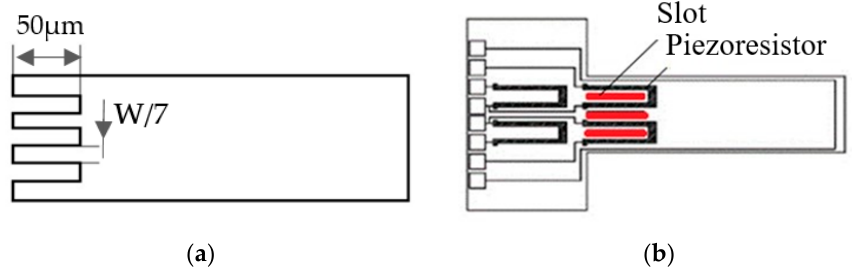
Figure 3. Top view of the slotted MCL-based mass sensor geometry. ( a ) Simplified outline of slotted MCL; ( b ) Geometry of slotted MCL with Wheatstone bridge.